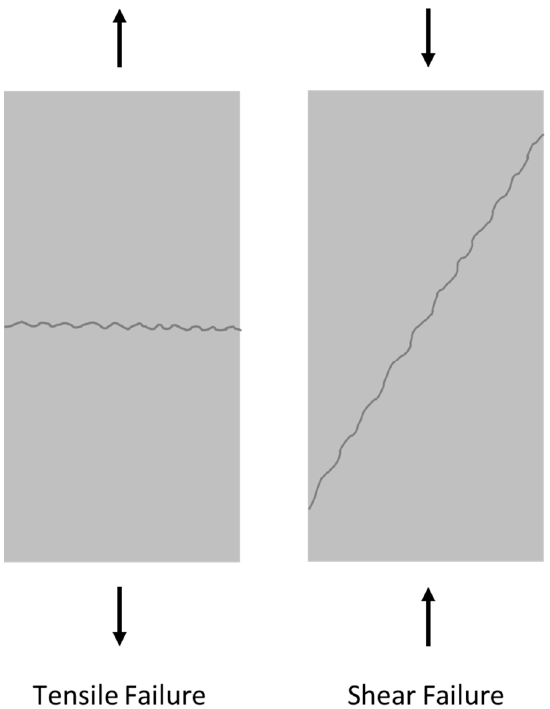
Figure 2. Illustration of tensile and shear failure of a 2D cylindrical sample. The arrows indicate the direction of the force being applied to the sample.